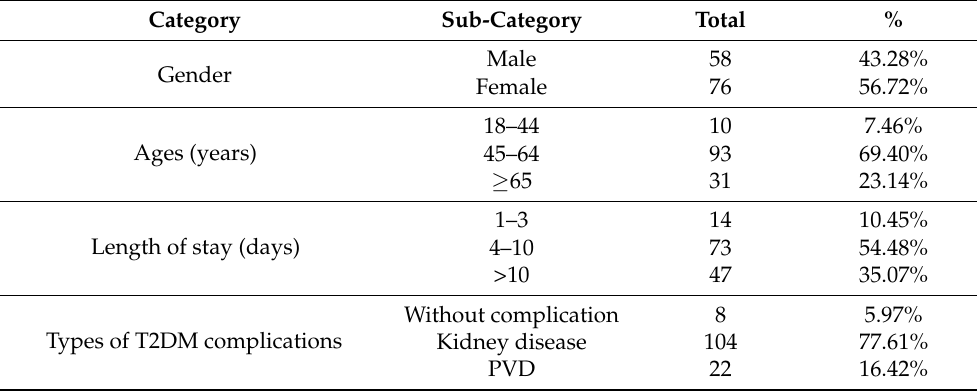
Table 1. Patients’ characteristics.